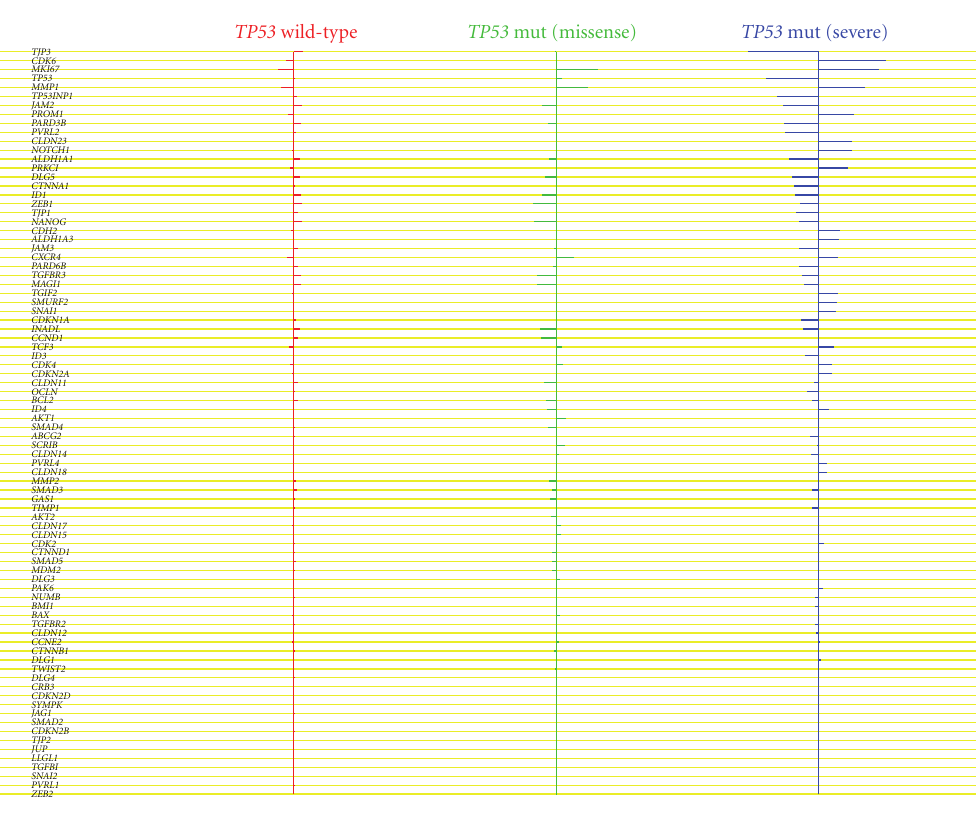
Figure 3: Shrunken centroids for wild-type TP53 an mutant (missense or severe mutation) TP53 tumors. Left-sided bars indicate lower expression in the subgroups relative to overall centroid; right-sided bars indicate higher expression in subgroups relative to overall